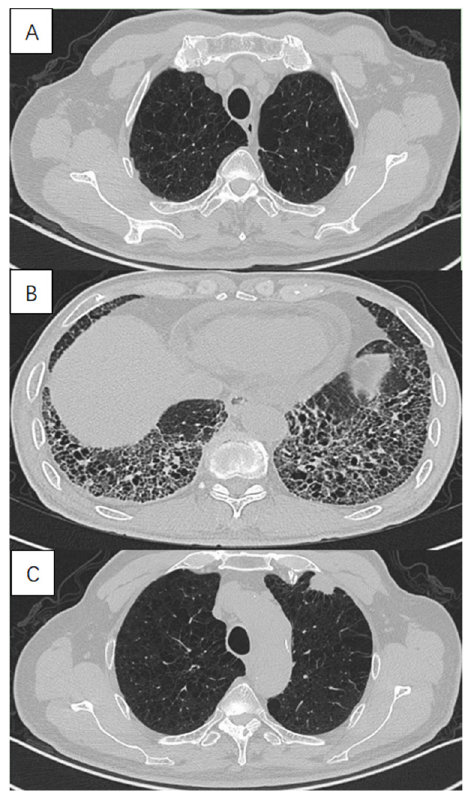
Figure 1. High-resolution computed tomography in a 72-year-old male with lung cancer with combined pulmonary fibrosis and emphysema (CPFE), showing ( A ) paraseptal emphysema in the upper lobe, ( B ) lower-zone-predominant fibrosis and ( C ) a solid mass in the subpleural emphysema area in the left upper lobe.